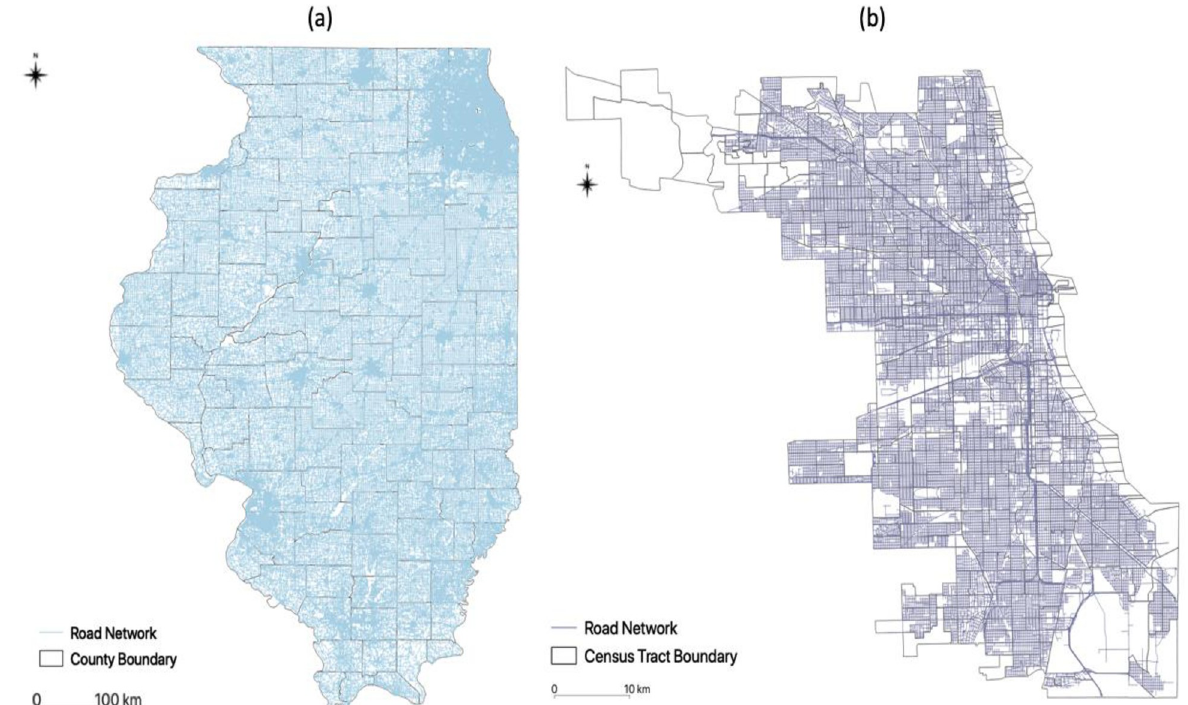
Fig 3. Road network: (a) Illinois and (b) Chicago. https://doi.org/10.1371/journal.pone.0270404.g003 Fig 4 illustrates how to delineate the catchment area per service site and how to measure a clinic’s spatial accessibility. The use of road network enables researchers to identify the nodes reaching to the travel time (e.g., 10, 20, and 30 minutes) from the service site. Then, a convex